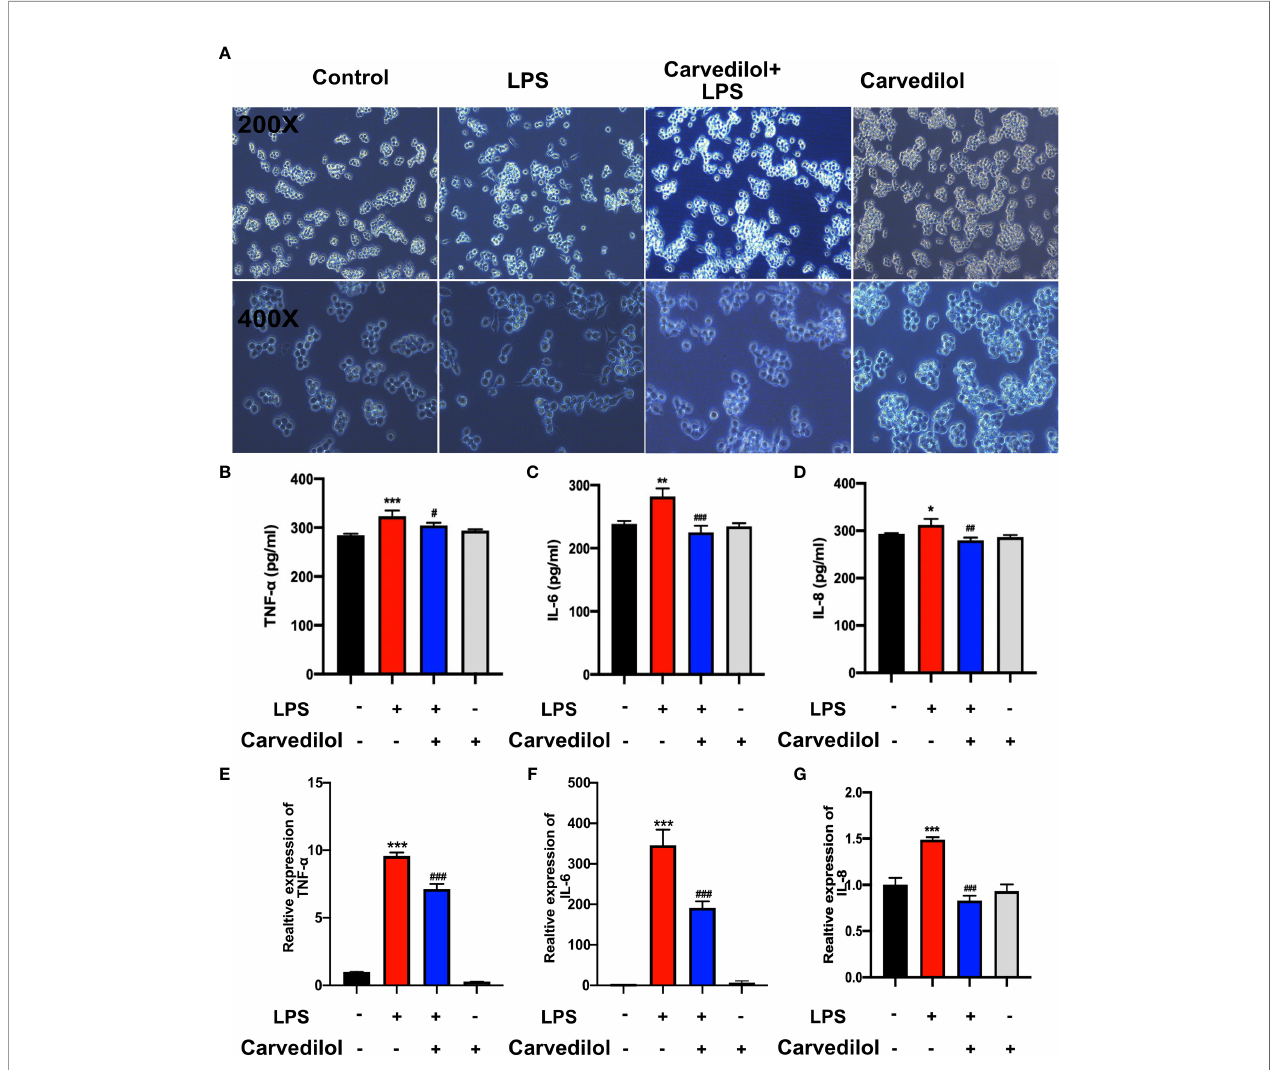
FIGURE 5 | Carvedilol alleviates the in fl ammation in RAW 264.7 cells induced by LPS. The in fl ammatory model was established by 12 h LPS exposure with or without carvedilol pretreatment for 30 min. (A) Cell morphology and statistical results of the polarization ratio. In the LPS group, the shape of cells changed from round to spindle, indicating the occurrence of in fl ammation. With carvedilol pretreatment, the morphology of the cells did not change so much, mostly appearing as round shape. (B – D) Statistical analysis results of ELISA for in fl ammatory factor protein (including TNF- a , IL-6, and IL-8). (E – G) Statistical analysis results of RT-qPCR for in fl ammatory factor genes. The results further veri fi ed that LPS-induced in fl ammation could be abolished by carvedilol. *P < 0.05, **P < 0.01, ***P < 0.001, # P < 0.05, ## P < 0.01, ### P <